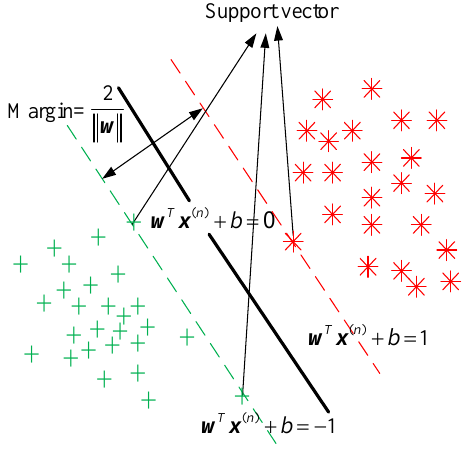
Figure 4. Support vector machine (SVM) model c (cid:13) 2019 IEEE